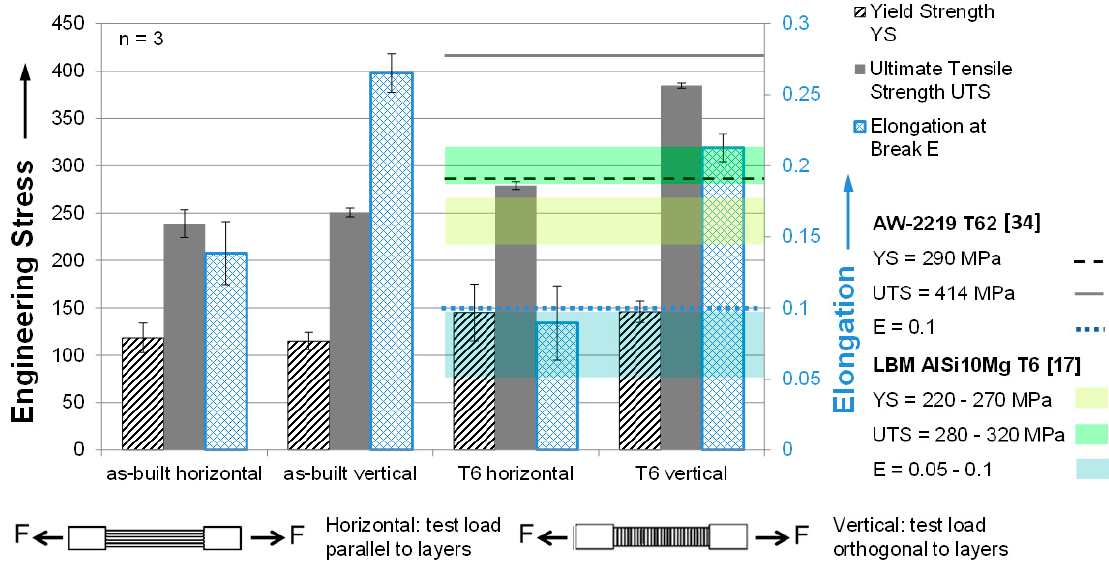
Figure 12. LBM AW-2219 tensile tests compared to literature values of conventionally manufactured EN AW-2219 T62 and LBM AlSi10Mg T6. No literature is known describing LBM EN AW-2219.